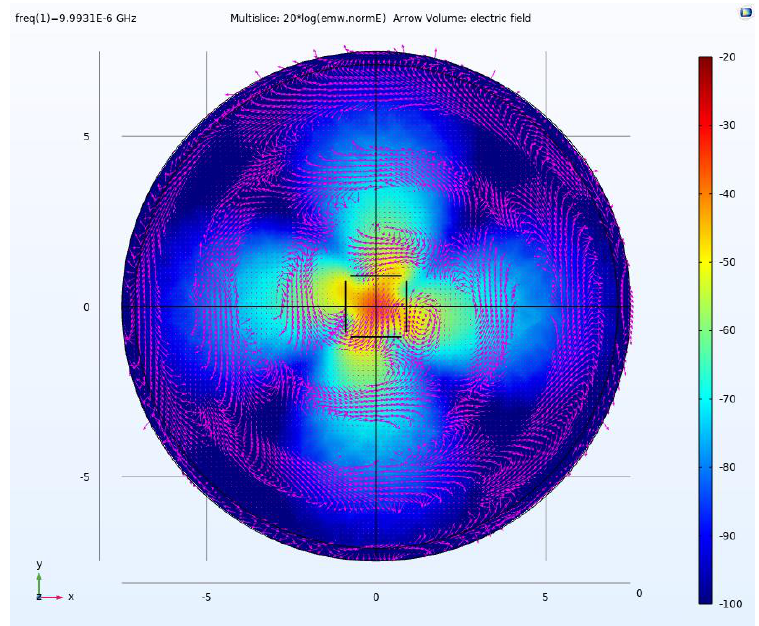
Figure 15. Electric field distribution and direction on the plane 5 km below the MD plane.